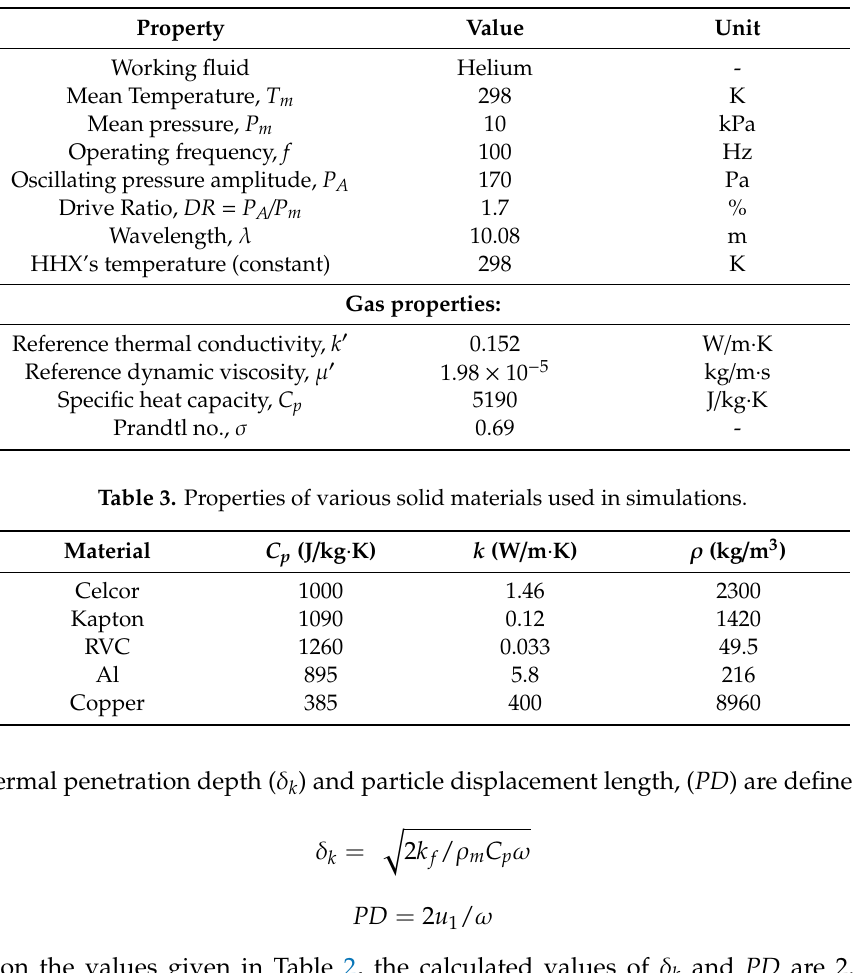
Table 2. Operating conditions and properties common to all simulations.